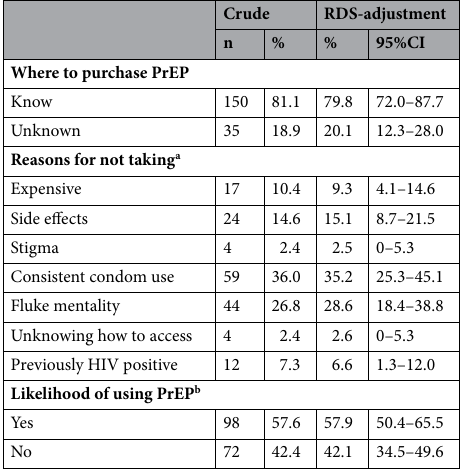
Table 2. Knowledge of PrEP among MSM recruited in 2021 in Beijing, China (n = 185) (Calculated for those who knew about PrEP). a Calculated for those who had not used PrEP, n = 164. b Calculated for those who were HIV negative, n =